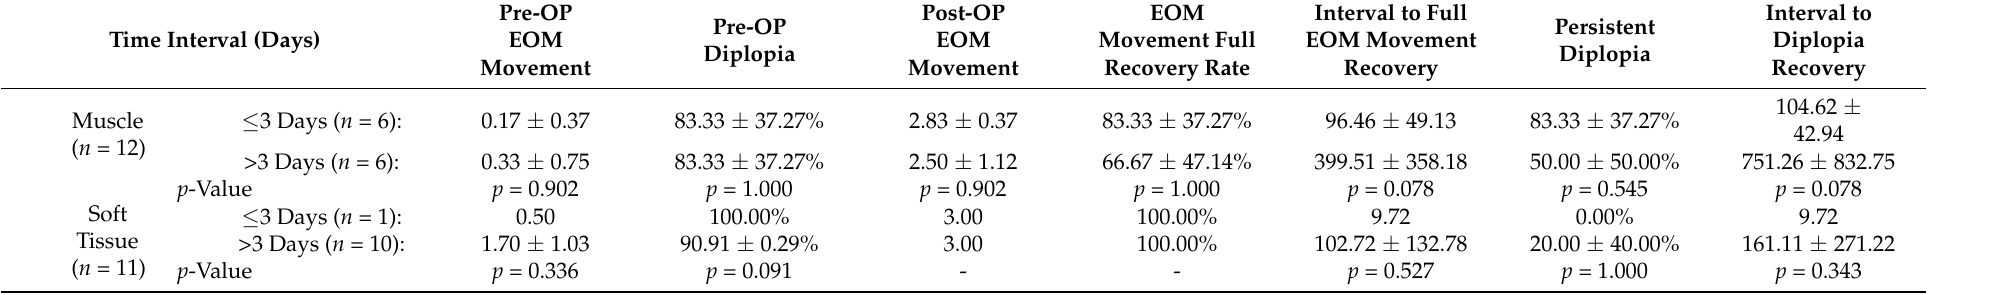
Table 6. Comparison of functional outcome by entrapment contains and subgroup of surgical timing